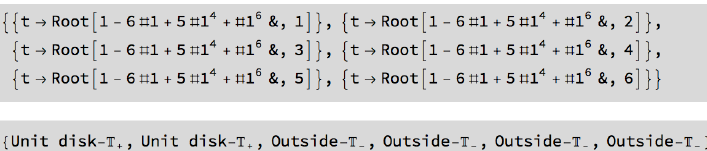
Figure 45. Output given by the [APoles] algorithm.